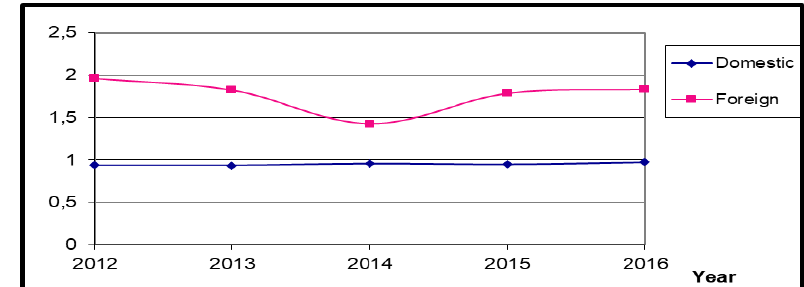
Figure 3: Comparison between domestic banks and foreign banks by using an annual average of current ratio for year 2012-2016